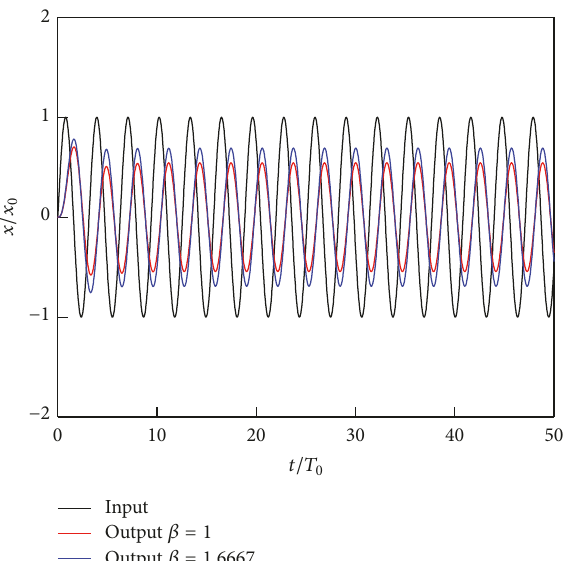
Figure 38: Response in the time domain ( 𝛼 = 3, 𝛽 = 1,1.6667, 𝜔/𝜔 = 2 ). 0